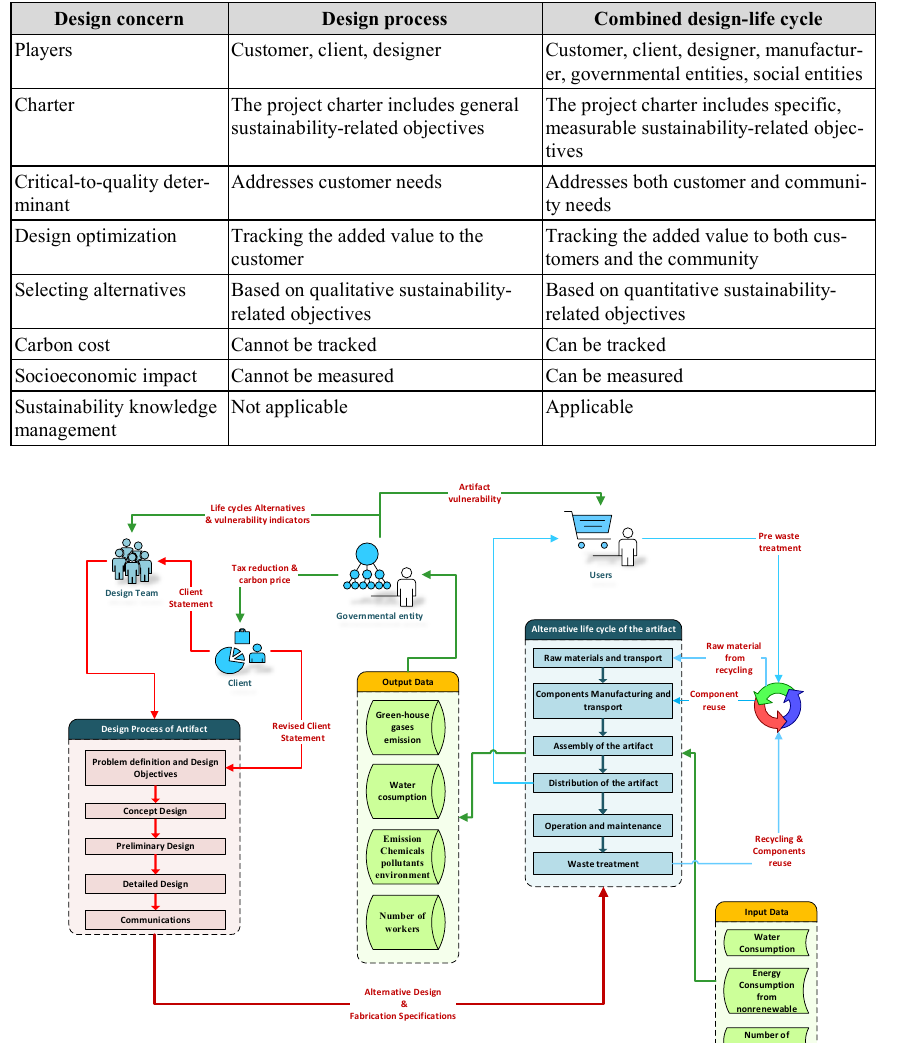
Table 1. Comparison between the design process and the combined design-life cycle approach Design concern Design process Combined design-life